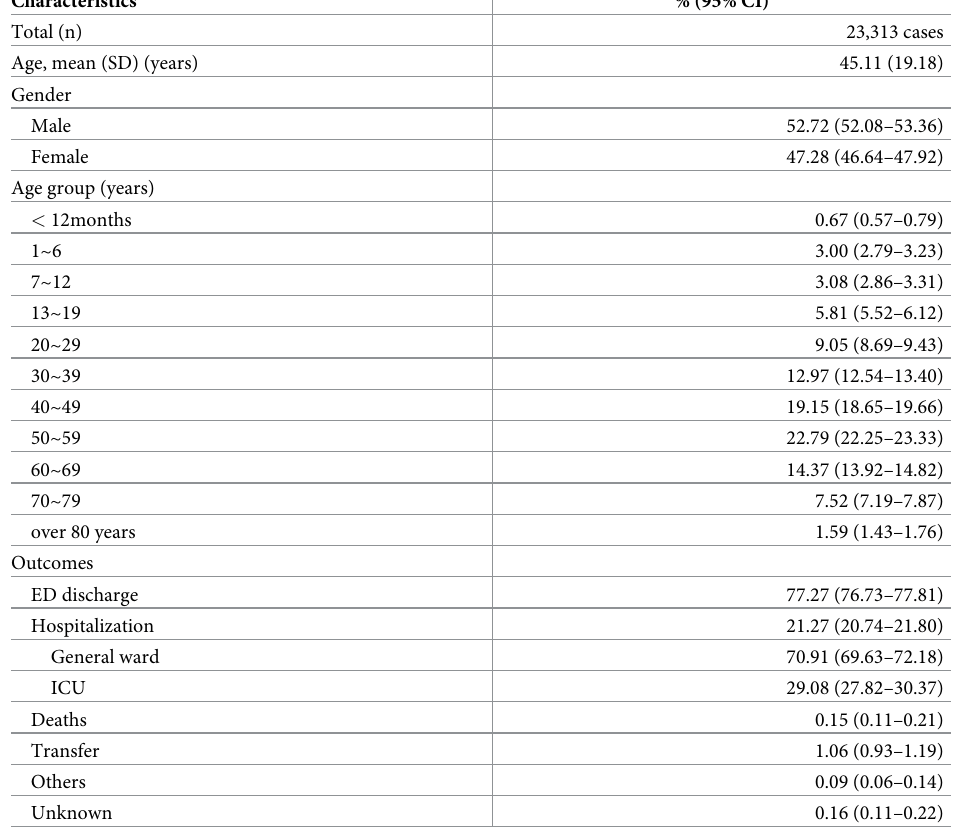
Table 1. Characteristics of ED visits with anaphylaxis, 2007–2013.